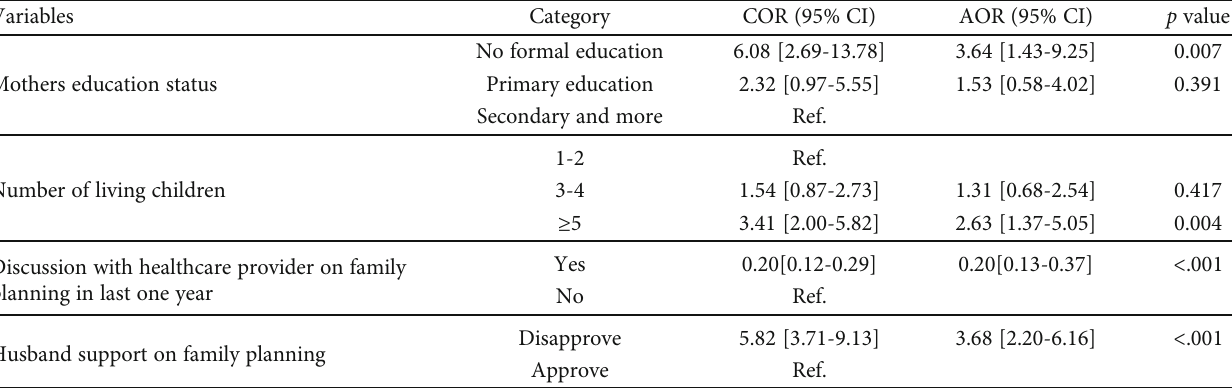
Table 4: Multivariate logistic analysis of independent variables associated with unmet need for family planning in Toke Kutaye district, West Shoa zone, Oromia, Ethiopia, March